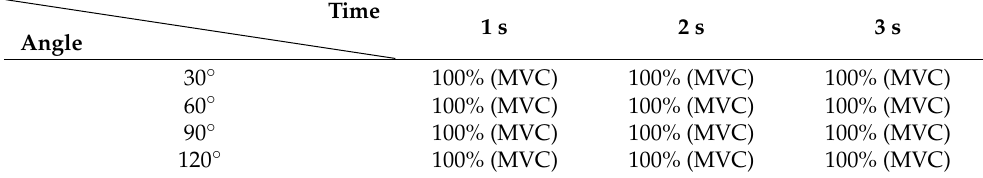
Table 3. Experiment procedures for each subject.